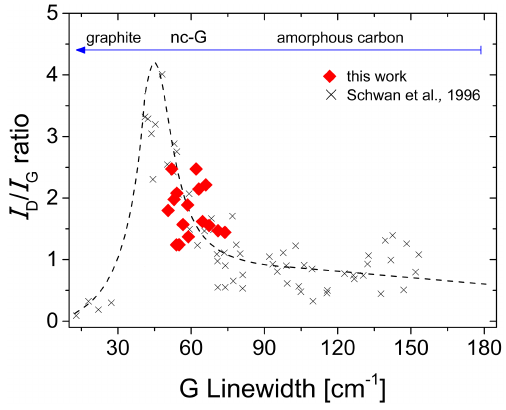
Figure 3. Ratio I D /I G vs. linewidth of G. The dashed line is a guideline for the eye taken from literature (Schwan et al., 1996). Increasing graphitization from amorphous carbon to nanocrystalline graphite (nc-G) and graphite is indicated by the arrow at the top.